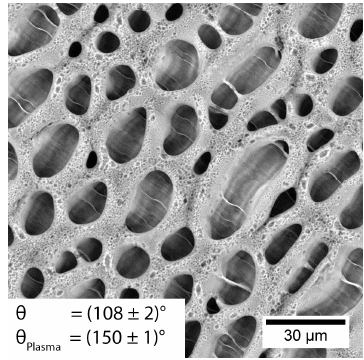
Figure 7. SEM micrograph of microtextured PS with a porous border. Water contact angles prior to and after plasma modification. Porous-borders were prepared by five doses of 2.5 THF:7.5 ETH at 303 K. The power of plasma reactor was 300 W.